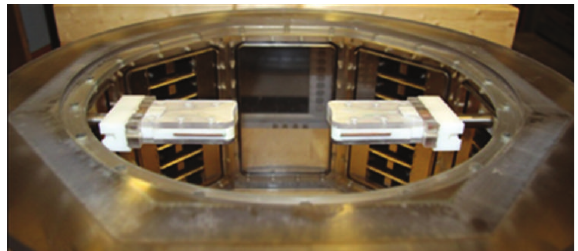
Figure 3: View of the measurement tank with the two sensors (Cassiopeia antenna) attached to movable arms.